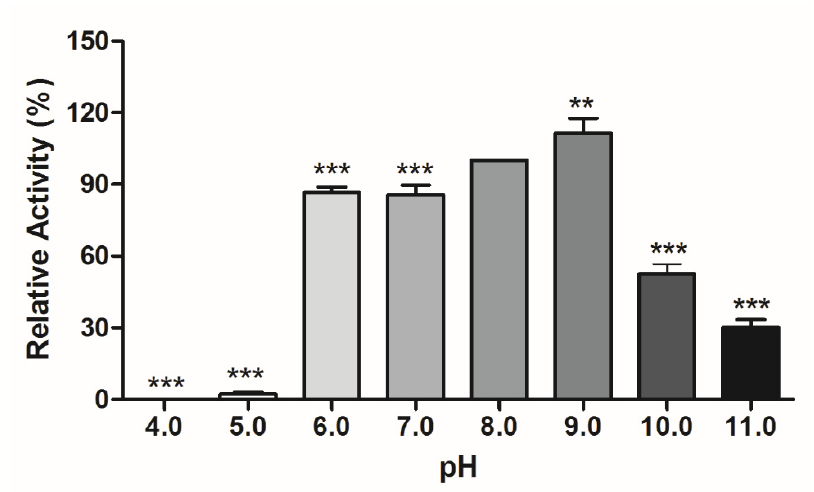
Figure 3. Effect of pH on lipase activity. ** Values significantly different from control (pH 8), according to ANOVA followed by Dunnett’s post hoc test ( p < 0.001). *** Values significantly different from control (pH 8), according to ANOVA followed by Dunnett’s post hoc test ( p < 0.0001). Mean and standard deviation.